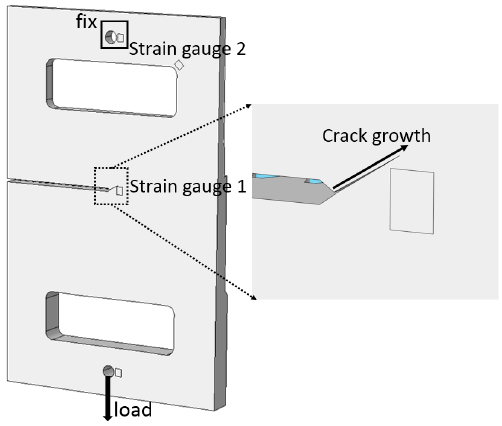
Figure 10. Static finite element model with different crack lengths in the growth direction.